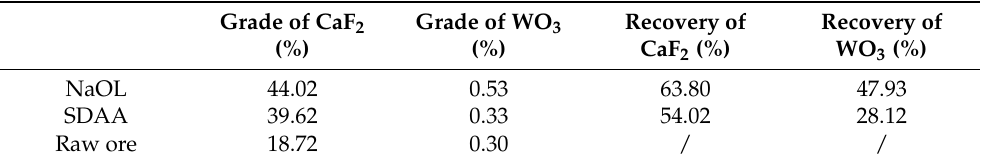
Table 1. Grade and recovery of CaF 2 and WO 3 in fluorite concentrate when the concentration of SDAA or NaOL was 100 g/t at pH 7.0 in actual ore